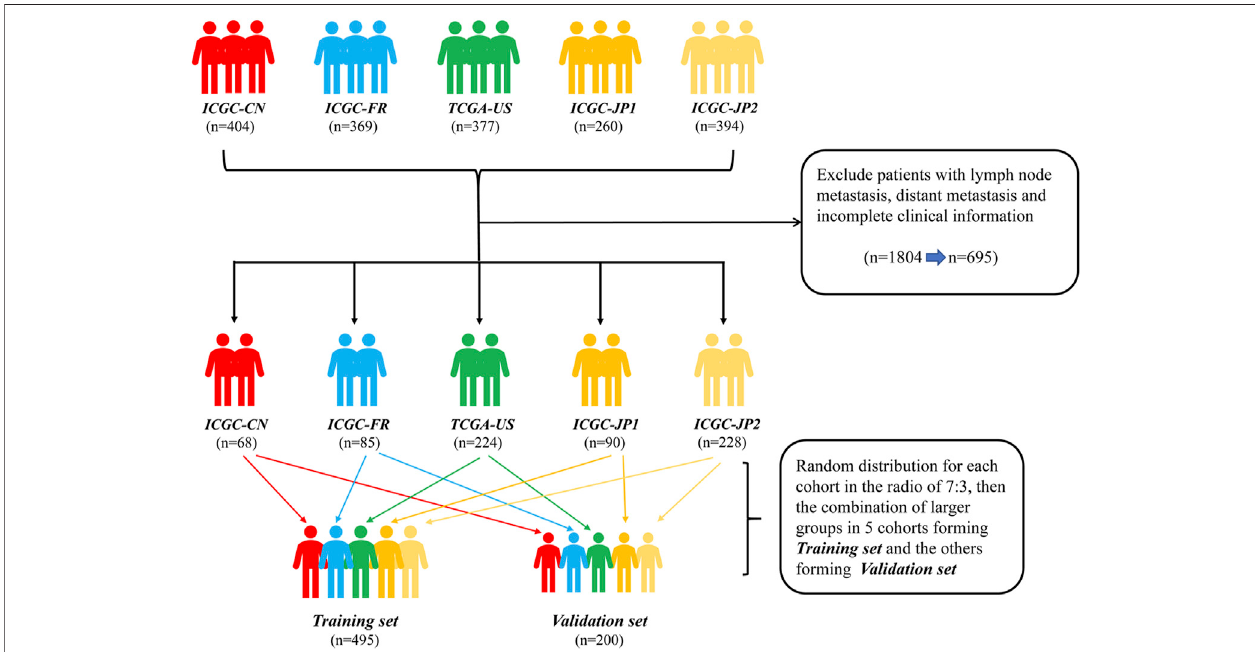
FIGURE 1 | Flow diagram of the HCC patients without distant and lymphatic metastasis in training and validation sets. ICGC-CN: LICA-CN, liver cancer-China; ICGC-FR: LICA-FR, liver cancer-France; TCGA-US: TCGA-LIHC, The Cancer Genome Atlas-liver hepatocellular carcinoma; ICGC-JP1: LIRI-JP, liver cancer RIKEN-